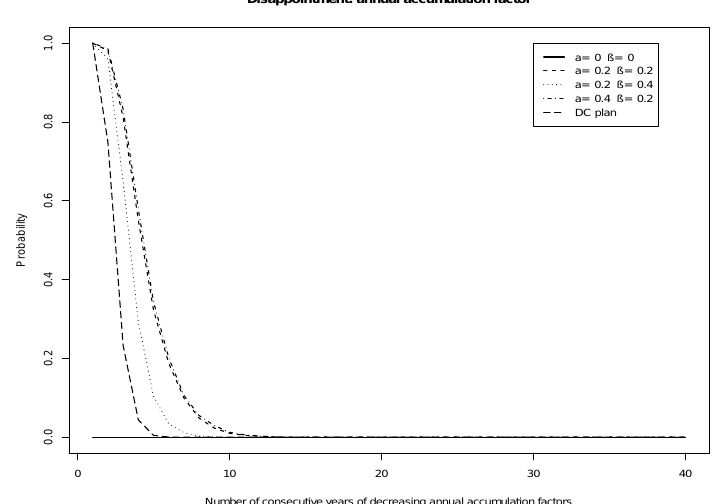
Figure 9. Disappointment for the more realistic membership when the target funding level ¯ F = 100%. The probability of a declining AAF plotted against the number of consecutive years that the decline occurs over. Both the investment risk adjustment ( a ) and the AAF adjustment ( b ) are varied.